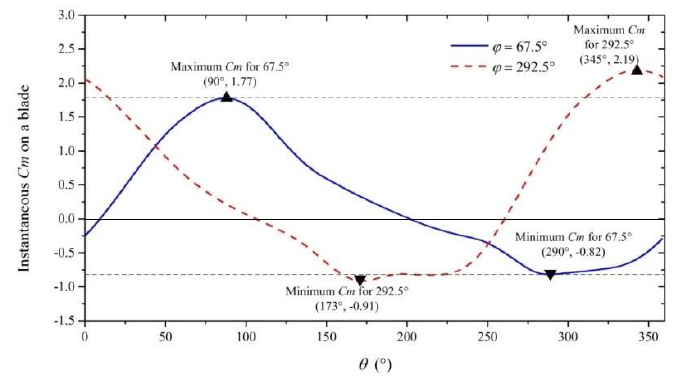
Figure 21. Instantaneous coefficients of torque on a blade at φ = 67.5° and 292.5° for TSR = 1.2.